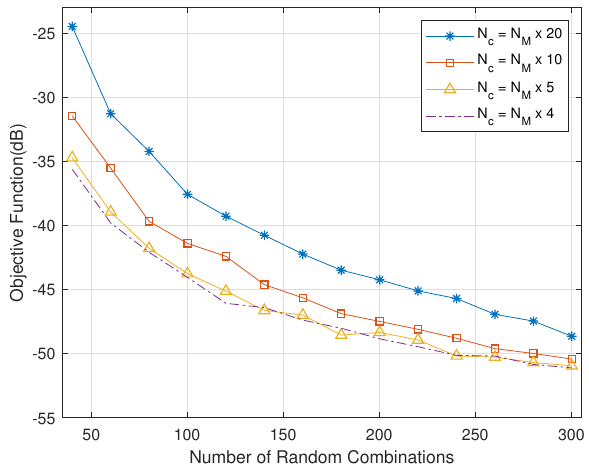
Figure 5. The relationship between random combination number and objective